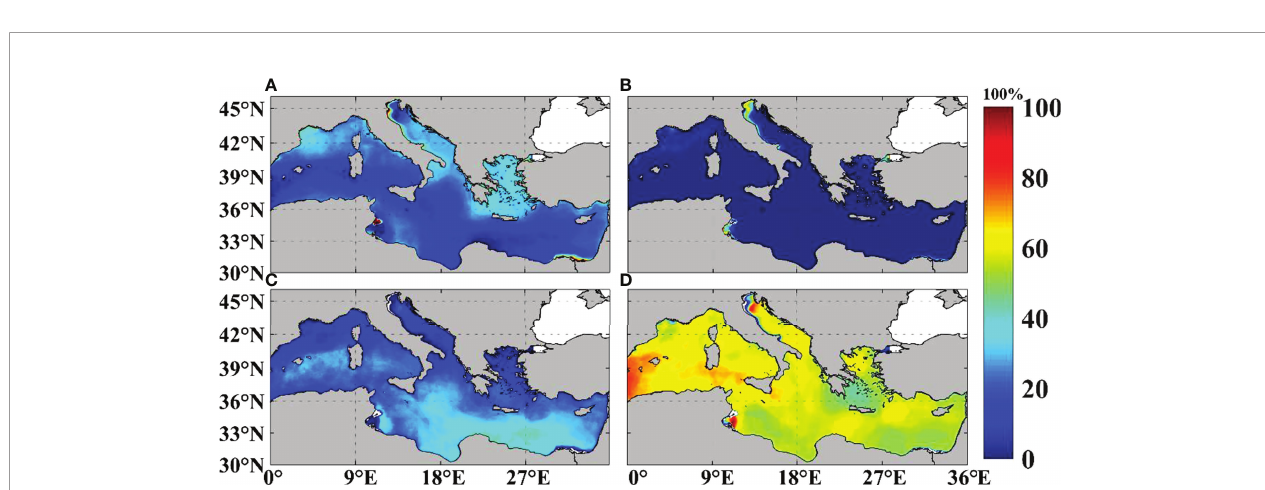
FIGURE 12 | Proportion of each pro fi le type in the Mediterranean Sea from 2011 to 2018. Panels (A-D) successively show the mixed, exponential, quasi-Gaussian and Gaussian